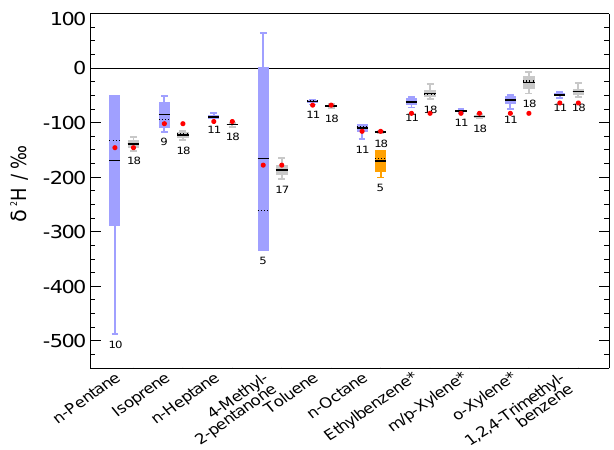
Figure 3. Compound-specific δ 2 H in different VOCs adsorbed on glass beads (blue boxes) and Tenax ® TA (grey boxes), respectively. The size of each box represents the standard deviation, minimum and maximum values are indicated by the whiskers, solid and dashed black lines mark the mean and median value, respectively. The numbers below the boxes indicate the corresponding number of measurements. The values obtained by Agroisolab are represented as red dots. The orange box represents the mean value and standard deviation of δ 2 H of n -octane measured while a degrading of the conditioning of the ceramic tube in the pyrolysis oven is observed (see Sect. 3.3.1) (*not comparable to the results of Agroisolab); see text for more